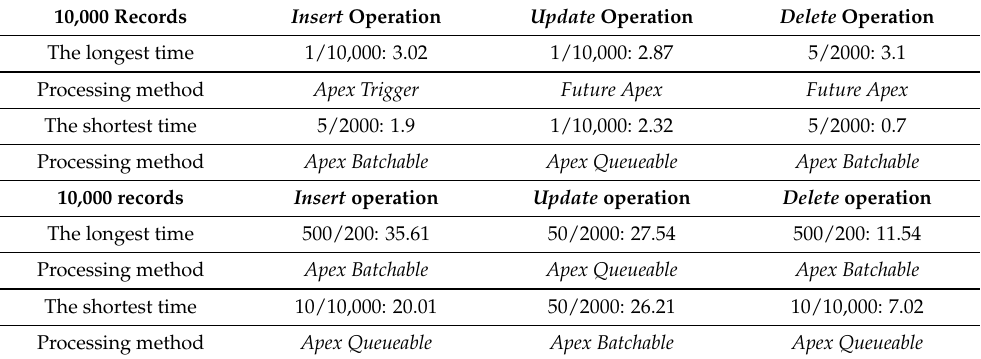
Table 16. The shortest and the longest processing time (seconds) on the server for data process- ing